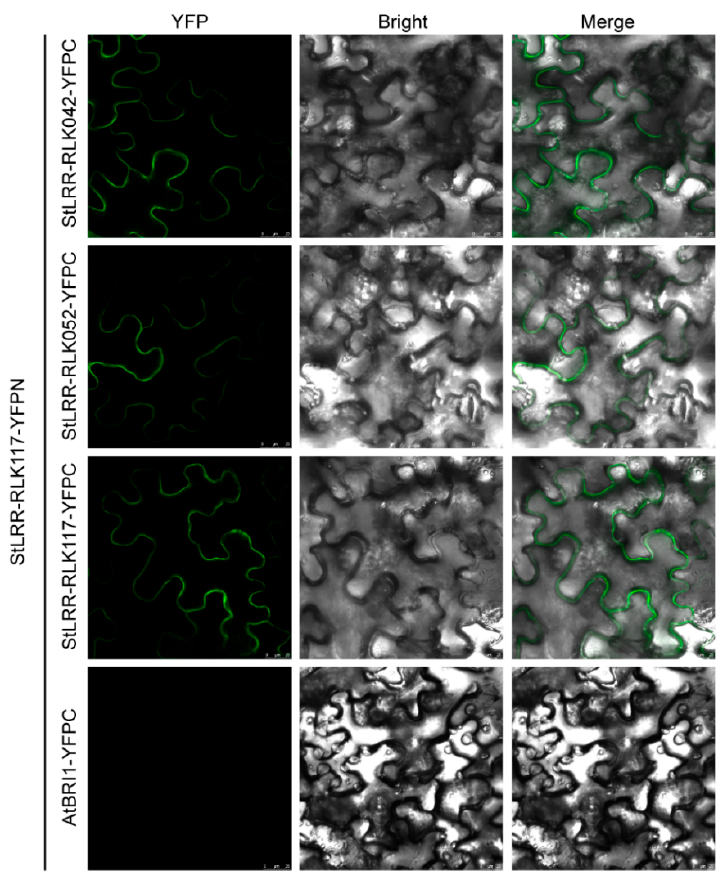
Figure 7. Transcriptional level of selected StLRR-RLK genes in various tissues by qRT-PCR. To reveal the tissue specificity, the expression level of the genes was represented as folds relative to the expression level of root. These qRT-PCR data presented here were obtained from three independent biological replicates with three technical repeats. St, shoot tip; S, stem; R, root; YL, young leaf; SL, senescence leaf; T, tuber.